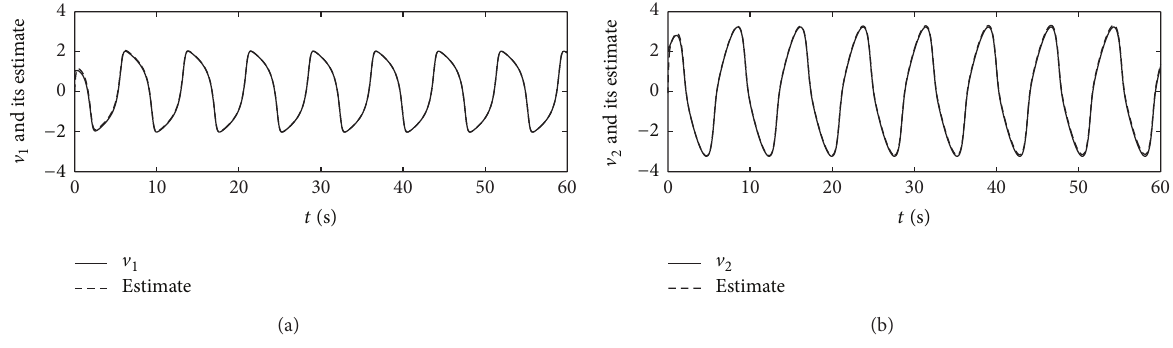
Figure 2: Nonlinear disturbance inputs V and their estimates.